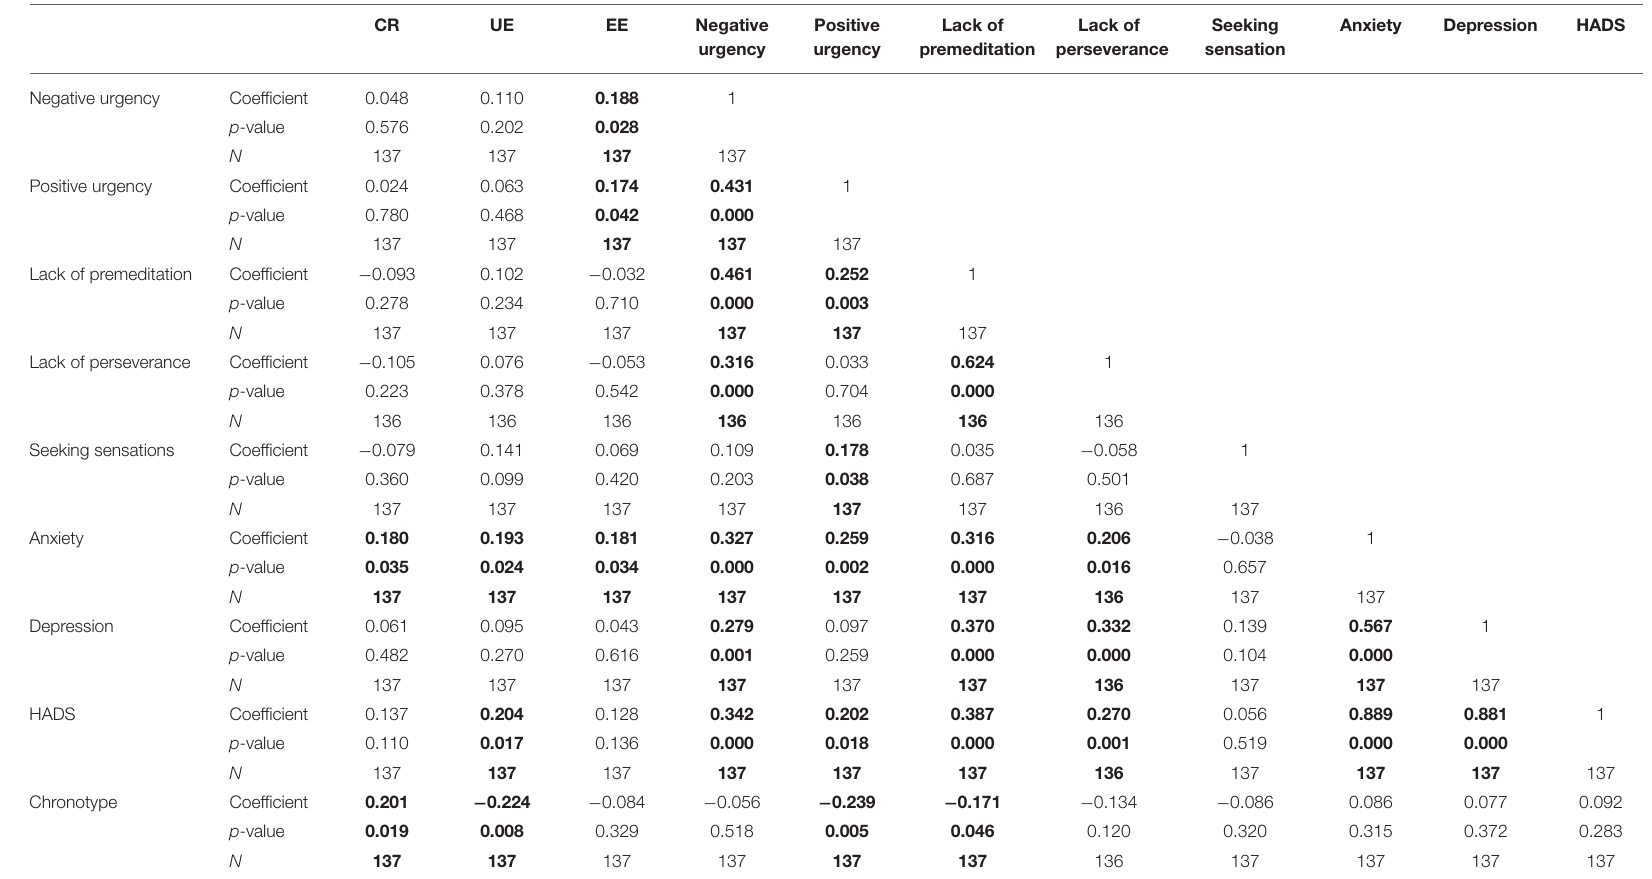
TABLE 6 | Correlations observed between the three aspects of eating habits and impulsivity, chronotype, anxiety, and depression among male participants.